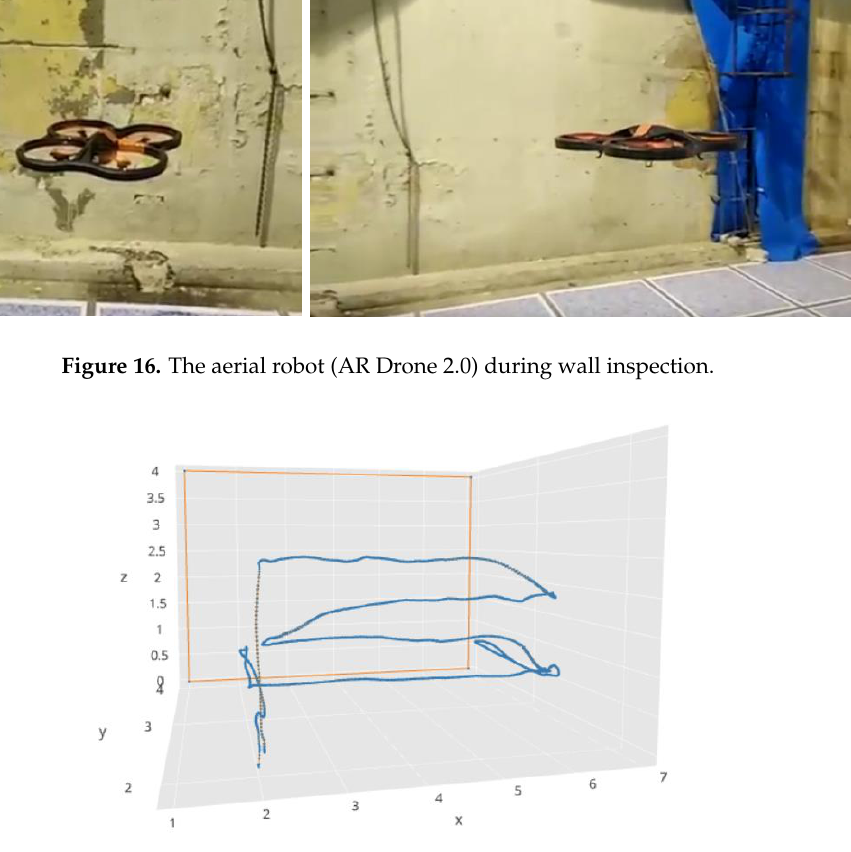
Figure 17. Example exploration trajectory followed by the robot in a real flight. In the figure, the orange line represents the wall and the blue line represents the trajectory followed by the aerial vehicle.